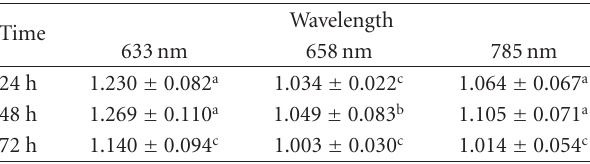
Table 1: The time-dependent responses of proliferation of HeLa cells in 5% FBS after three red lasers stimulation (Laser energy density and its irradiation time were 1000 J/m 2 and 100 s,